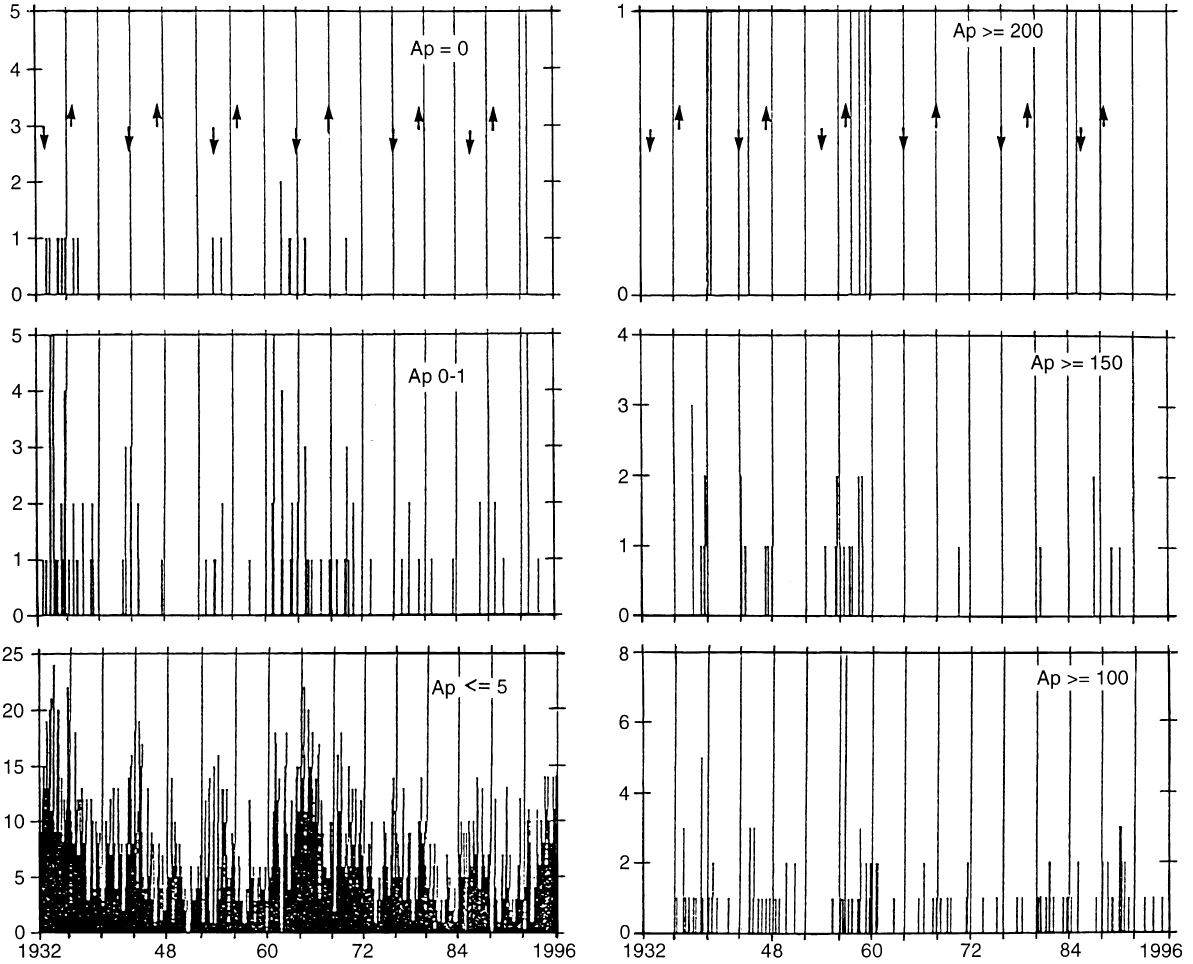
arrows indicate solar maximum epoch and downward